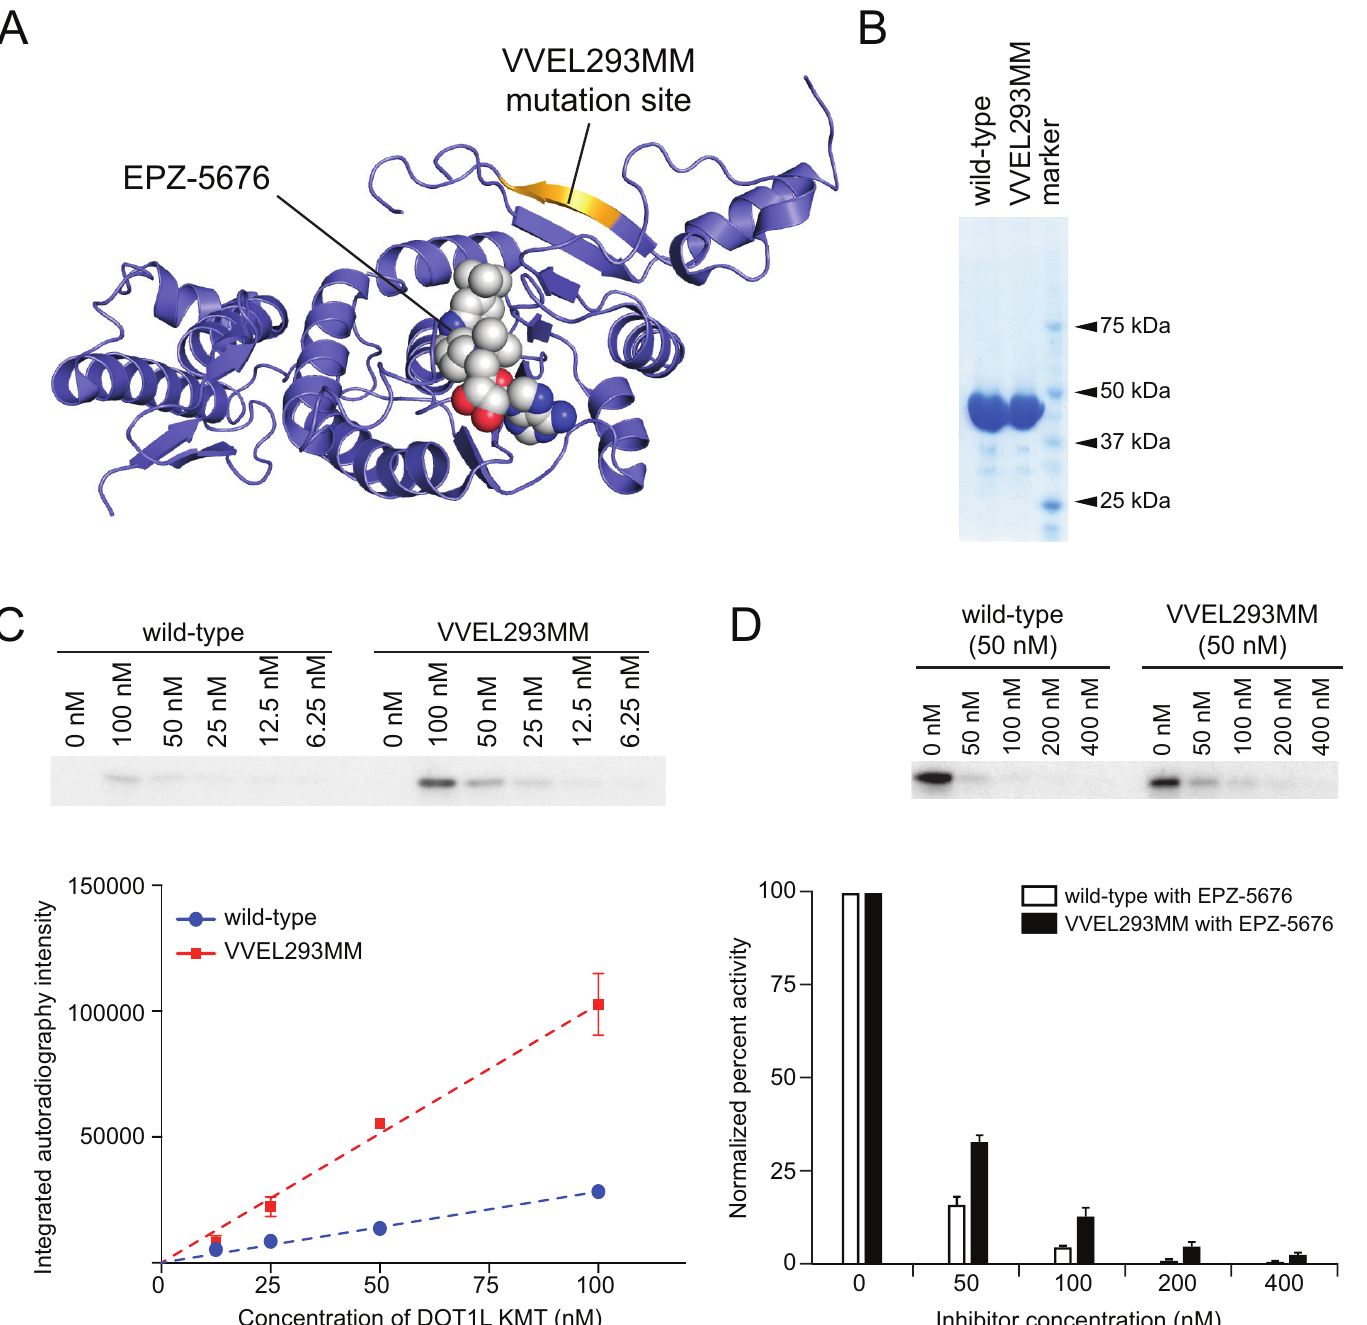
Fig 2. Biochemical analysis of DOT1L VVEL293MM lysine methyltransferaseactivity. ( A ) Crystal structure of DOT1L KMT domain bindingwith the EPZ-5676. The VVEL293MMmutation site was colored in yellow (PDB: 4HRA). ( B ) SDS-PAGE gel of purifiedrecombinant DOT1L KMT domainsof both wild-typeand VVEL293MMmutant proteins. ( C ) Relative in vitro KMT activity of DOT1L wild-type and VVEL293MMmutant protein. The in vitro KMT activity was determined by a biochemicalmethyltransferase assay, which measuredthe methyltransfer level of radiolabeled SAM to purifiednucleosomalsubstrates in the presenceof a wild-typeor mutant enzyme. To ensurethat quantifications were made in the linear range of detection, the assay was performed at severalDOT1L concentrations. The top panel shows a representative SDS-PAGE gel autoradiograph of the in vitro KMT assay with KMT proteinsand concentrations of EPZ-5676 indicated.The lower panel plots the averageintegratedautoradiographyintensity from two independentpreparations of wild-type and mutant DOT1L KMT proteins. ( D ) Relativesensitivitiesof wild-typeand VVEL293MMDOT1L to EPZ-5676. To normalizefor the difference in basal activity betweenthe wild-typeand VVEL293MM DOT1L, the in vitro KMT assay reactionvolume of the wild-typeprotein was increasedthree-fold. The top panel shows a representative SDS-PAGE gel autoradiograph of the in vitro KMT assay with KMT proteins and EPZ-5676 concentrations indicated. The lower panel plots the averageresults from three independent enzymatic preparations. All error bars shown represent s.e.m.